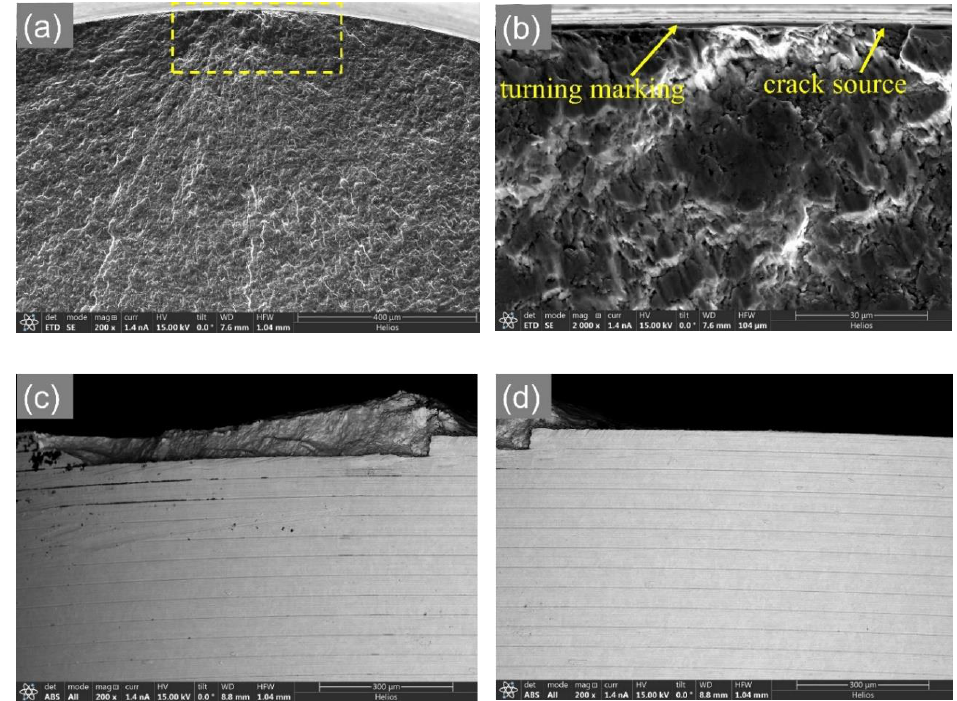
Figure 10. Fracture surface and surface morphology of a turned sample tested at σ a = 700 MPa and failed with N f = 1.5 × 10 6 in the HCF regime: ( a ) fracture surface showing surface crack initiation, ( b ) magnified image of the rectangular area in ( a ) revealing that the crack initiated from a turning mark, ( c , d ) morphological features near the crack initiation site on the turned surface revealing that the crack seemingly initiated from a specific turning mark and propagated rapidly along another turning